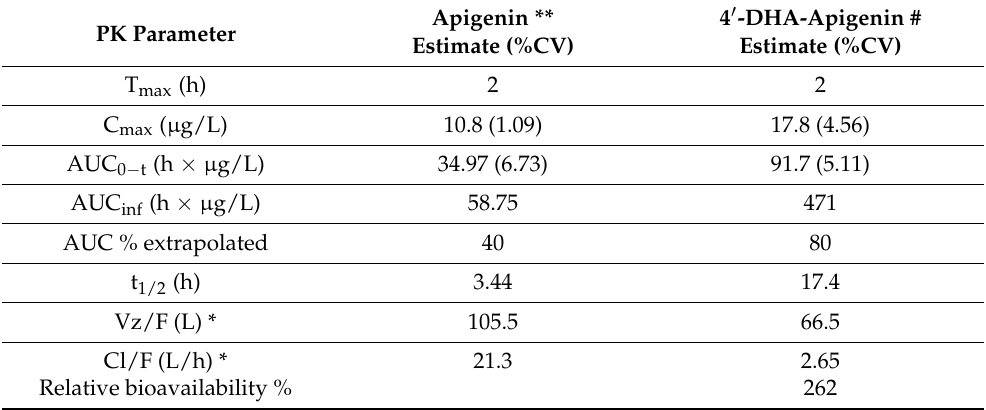
Figure 7. Pharmacokinetic profile of native apigenin and 4 ′ -DHA-apigenin in serum, after oral administration in mice, using olive oil as the vehicle (error bars represent ± SD of measured apigenin and 4 ′ -DHA-apigenin concentration). Table 3. Serum PK parameters of apigenin and 4’-DHA-apigenin after oral administration.